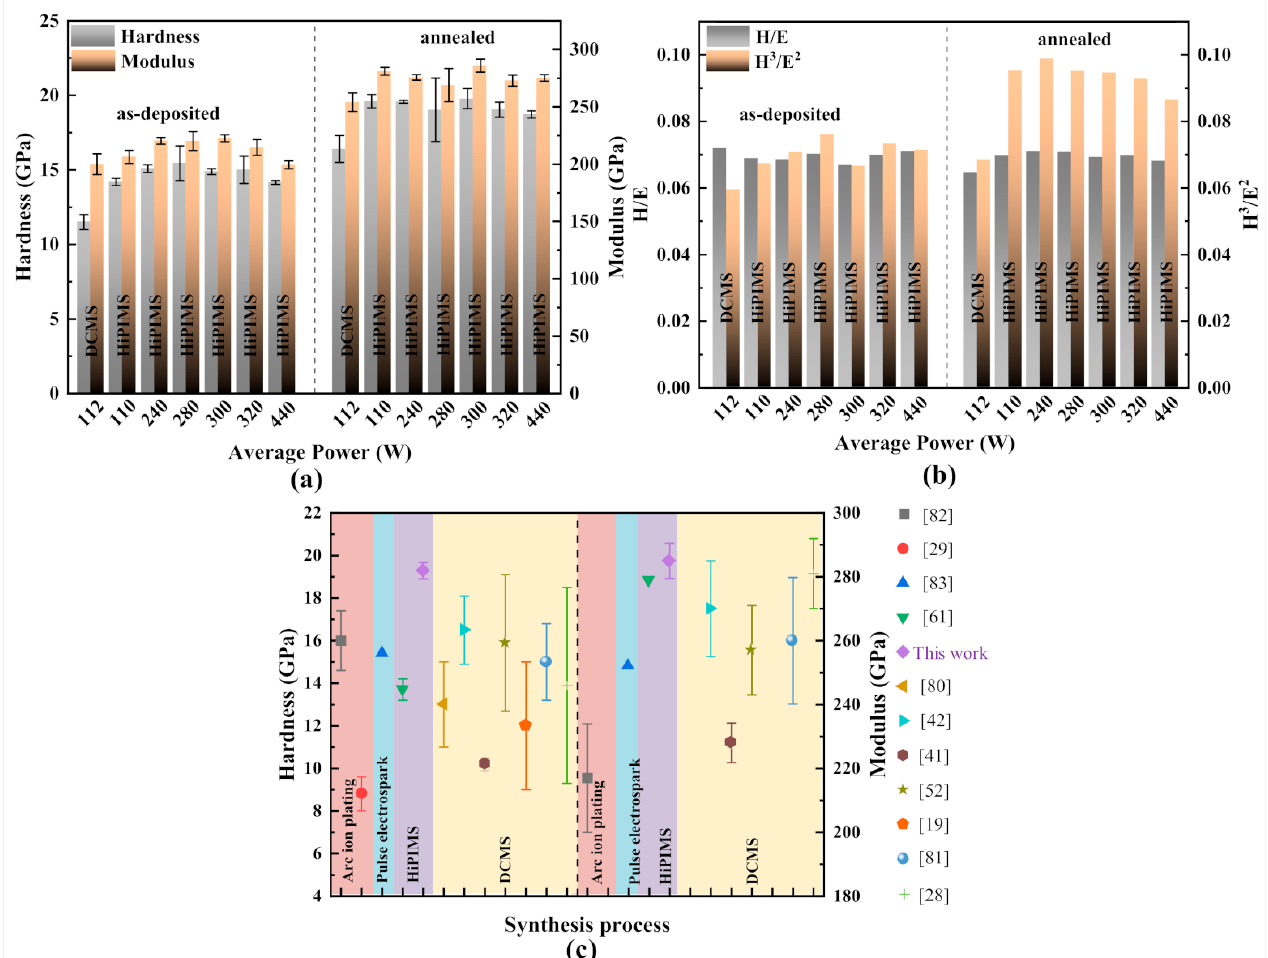
Figure 10. ( a ) The hardness (H) and elastic modulus (E), ( b ) H/E and H 3 /E 2 value of Cr 2 AlC MAX phase coatings before and after annealing, and ( c ) comparative results of hardness and elastic modulus of Cr 2 AlC MAX phase coatings of our work and the references